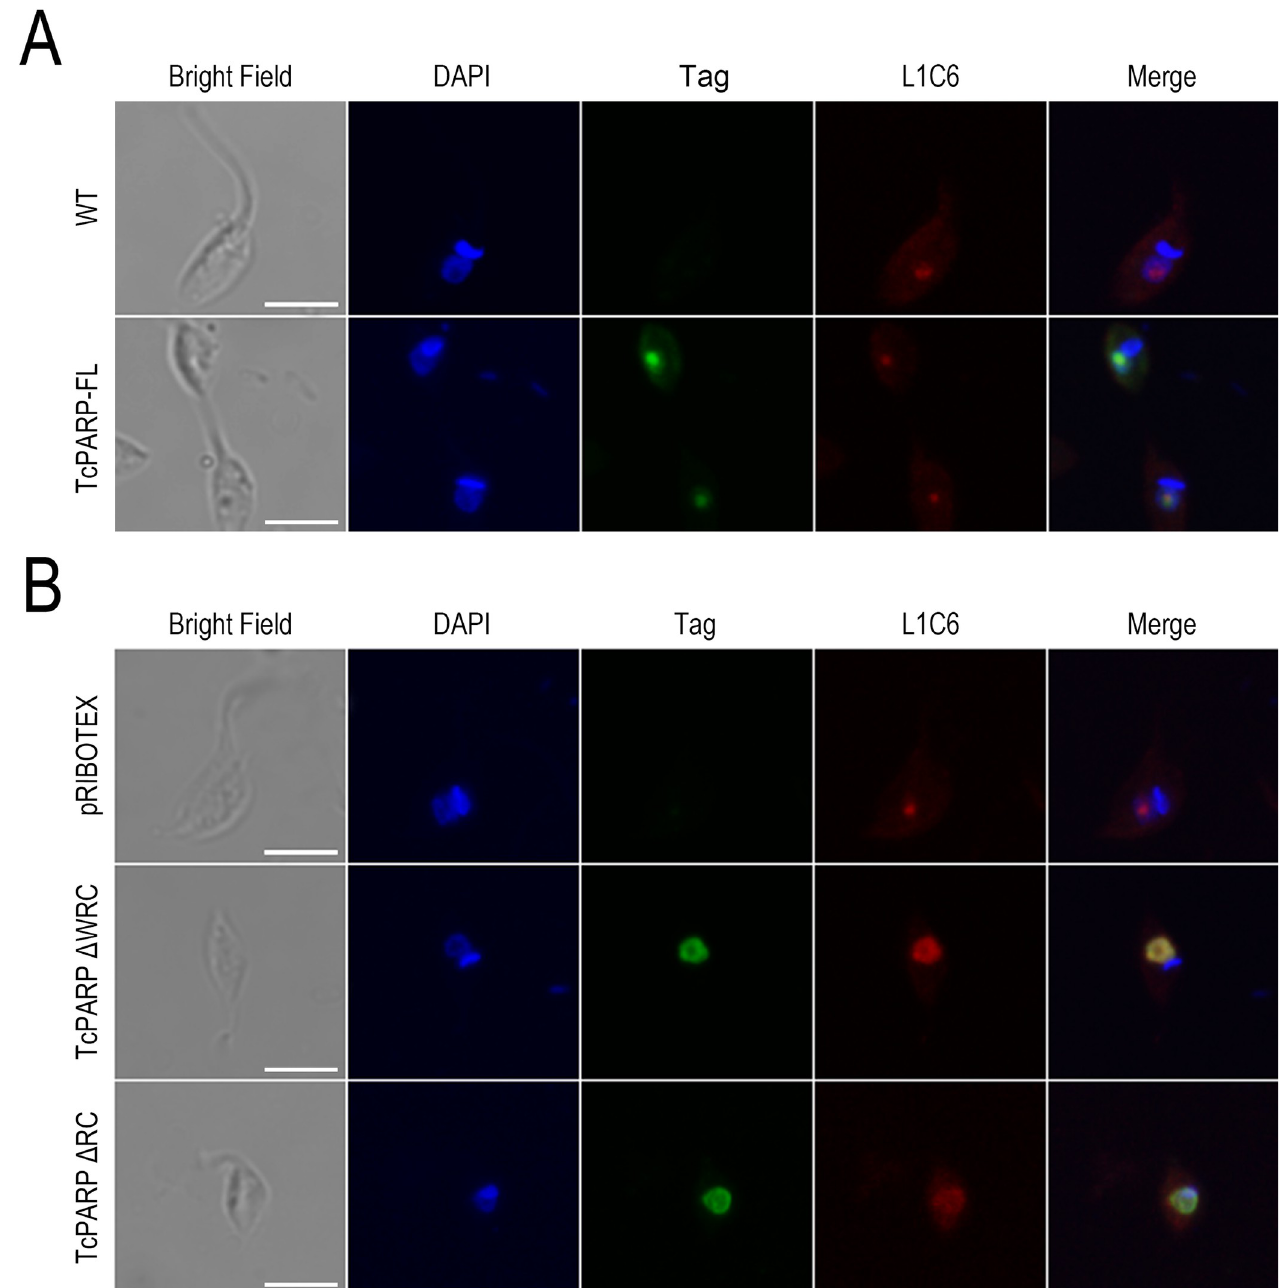
Fig 1. Colocalization of TcPARP constructs with nucleolus marker L1C6. (A) Indirect immunofluorescence (IF) of wild type or TcPARP-FL overexpressing epimastigotes. (B) IF of epimastigotes overexpressing the empty vector pRIBOTEX, TcPARP Δ WRC or TcPARP Δ RC. In both cases, detection of the nucleolar region was performed using an antibody directed against L1C6 and the TcPARP construct with the corresponding anti-tag antibody. Scale bar: 5 μ m. Pearson Correlation Coefficients (PCC), which ranges from − 1 to +1 (from anti-colocalization to complete colocalization), were determined: 0.85; 0.93 and 0.61 for TcPARP-FL, TcPARP Δ WRC and TcPARP Δ RC